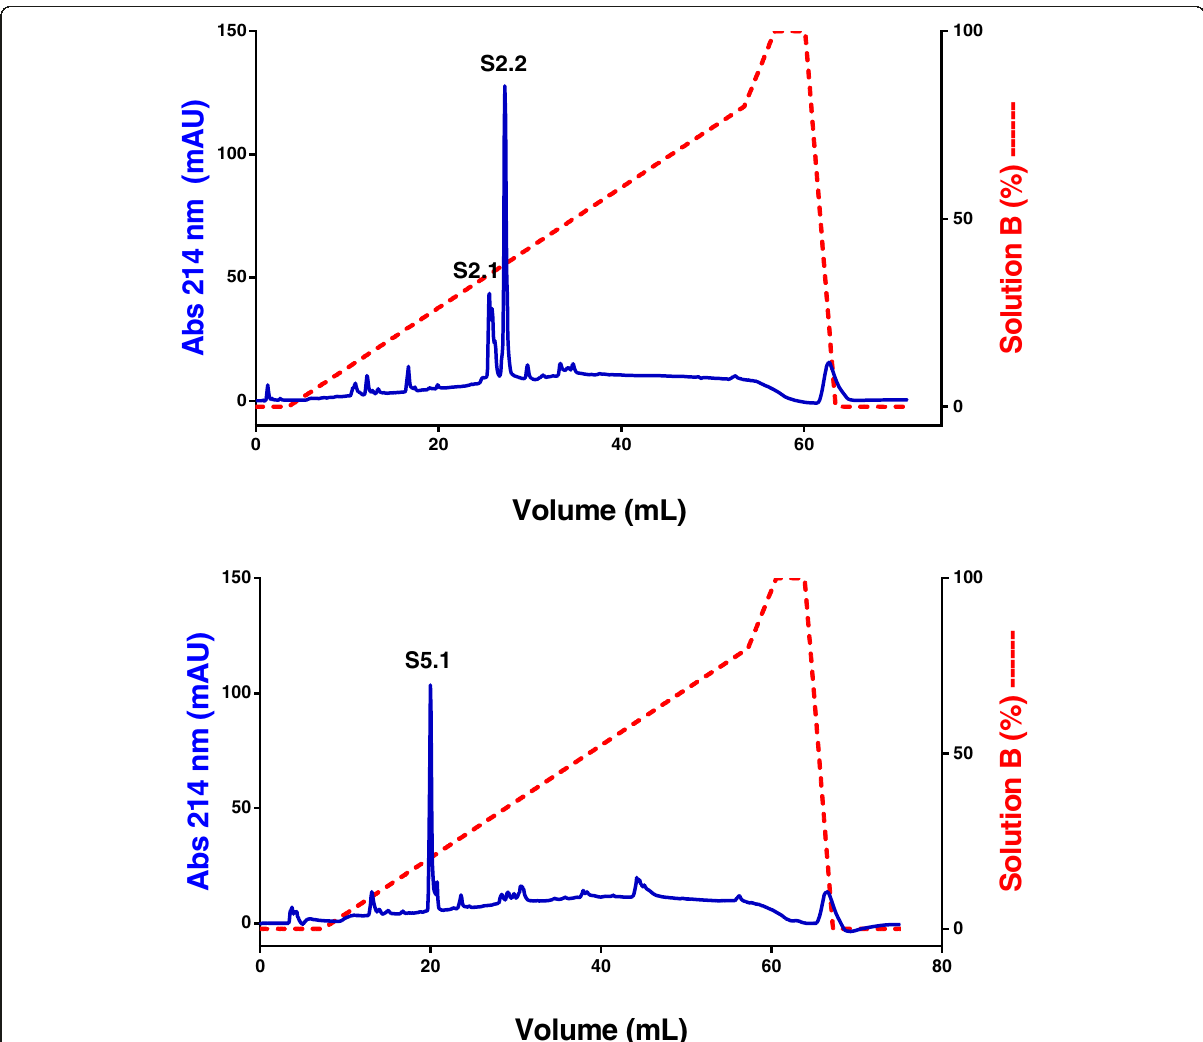
Fig. 2 Reversed-phase FPLC of fractions S2 and S5. The C2C18 column was equilibrated with 0.1 % (V/V) trifluoroacetic acid (TFA, solution A). Adsorbed proteins were eluted using a concentration gradient from 0 to 100 % of solution B (80 % acetonitrile in 0.1 % TFA, V/V). Fractions of 0.5 mL/tube were collected at a flow rate of 0.5